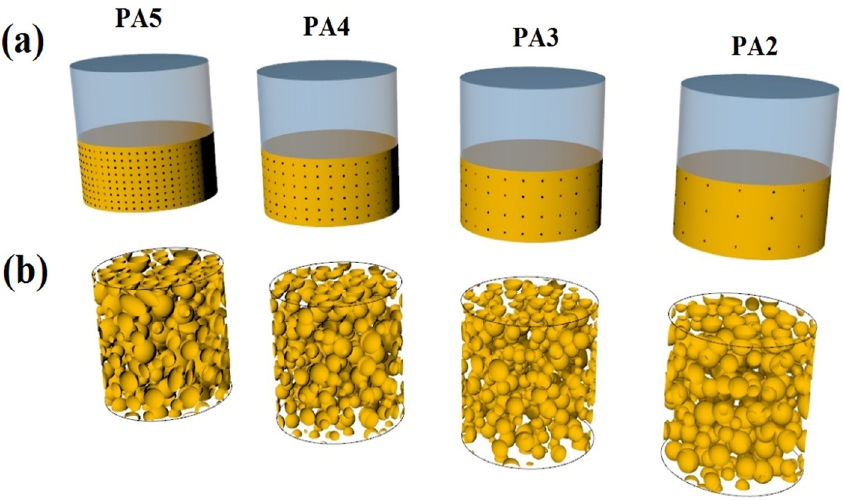
Figure 3. Schematic representation of the foaming process with different foaming agent contents’ (( a ) first row) nucleation with concentration and ( b ) final structure.